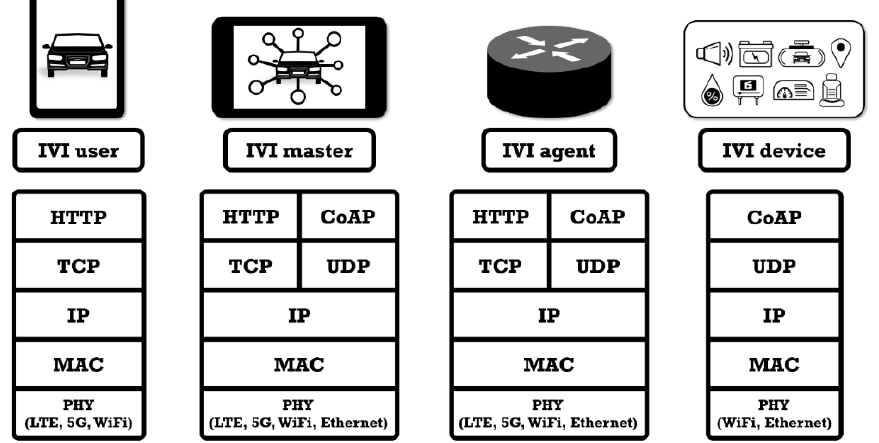
Figure 18. Protocol stacks for implementation of A-IVI entities .